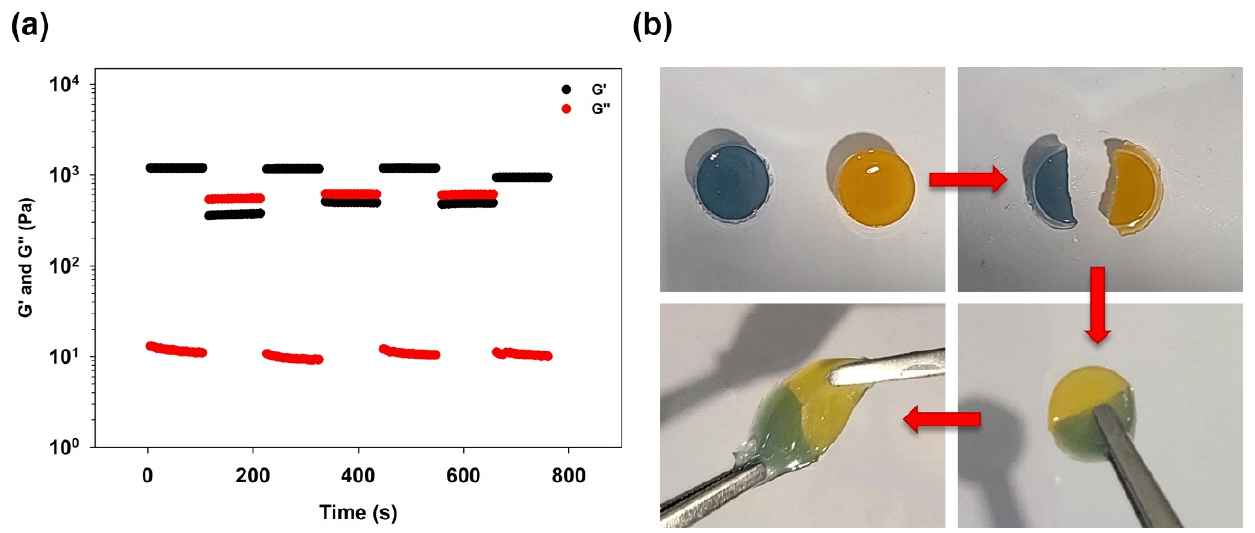
Figure 6. Step-strain measurements of the OSG3/P(NIPAM-AM) hydrogel to elucidate its self-healing properties ( a ). Photographic images showing the hydrogel crosslinking and its self-healable properties ( b ).